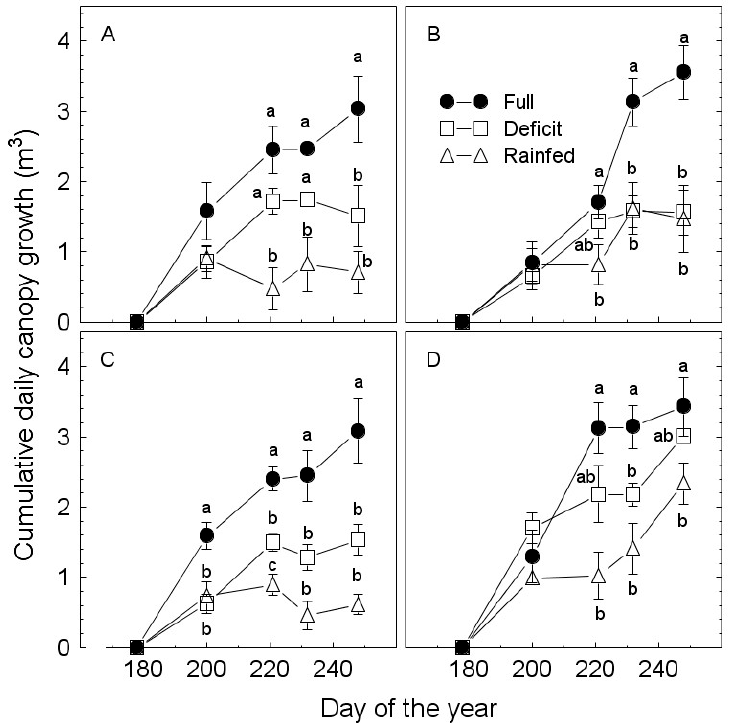
Figure 6. Seasonal increment of cumulative daily canopy growth estimated by the UAV-VIS imagery of olive trees cultivar Frantoio ( A , B ) and Leccino ( C , D ) subjected to full irrigation, deficit irrigation, or rainfed conditions in 2019 ( A , C ) and 2020 ( B , D ). Symbols are means of four trees ± standard errors. Different letters indicate differences between irrigation treatments after an ANOVA ( p < 0.05) within each date of measurement. Canopy volume increments were normalized against values at the beginning of the experiment (canopy volume = 0). Table 1. Fruit yield, oil yield, maturation index, and oil in mesocarp measured at harvest in olive trees (cvs. Frantoio and Leccino) subjected to full irrigation, deficit irrigation, or rainfed conditions in 2019 and 2020. Fruit and oil yield are also expressed on trunk cross sectional area (TCSA) basis. Values are means ± standard errors of four trees (n = 4). Different letters indicate significant differences between irrigation treatments after an ANOVA within each year and cultivar. LSD, least significant difference ( p ≤